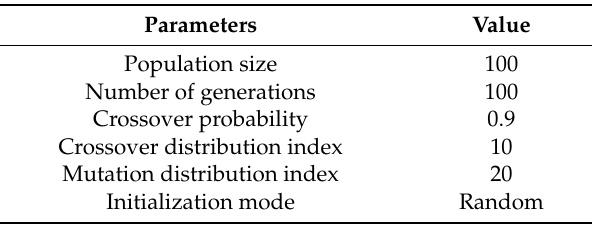
Table 4. Parameter settings for NSGA-II.